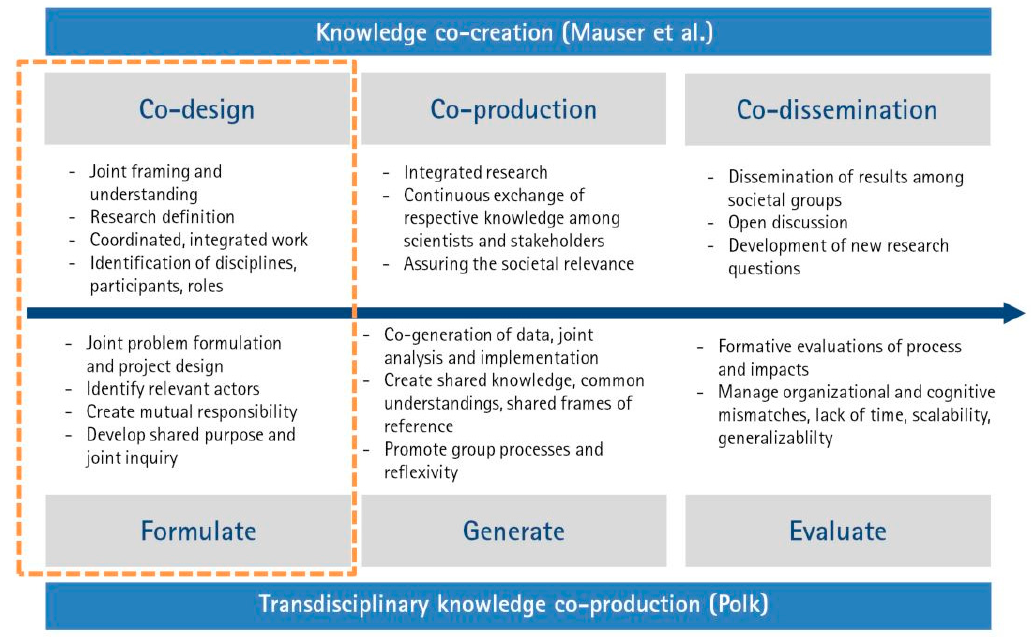
Figure 1. Comparison of two approaches of knowledge co-production processes with the initial point of the paper.